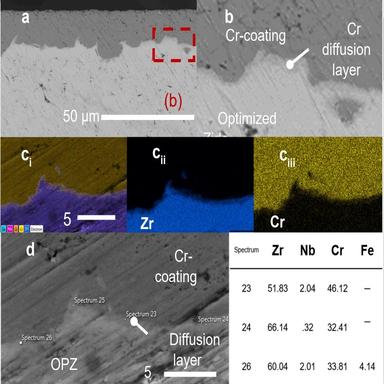
SEM of Cr-coated OPZ quenched from 900 ◦C; (a) Cr/Zr interface showing the roughness caused by the cold spray deposition method; (b) high magnification of the Cr/Zr interface showing the Cr diffusion into the OPZ substrate; (c) EDS of internal oxidation showing zirconium and chromium; (d) location of point measurements of EDS along the diffusion layer.